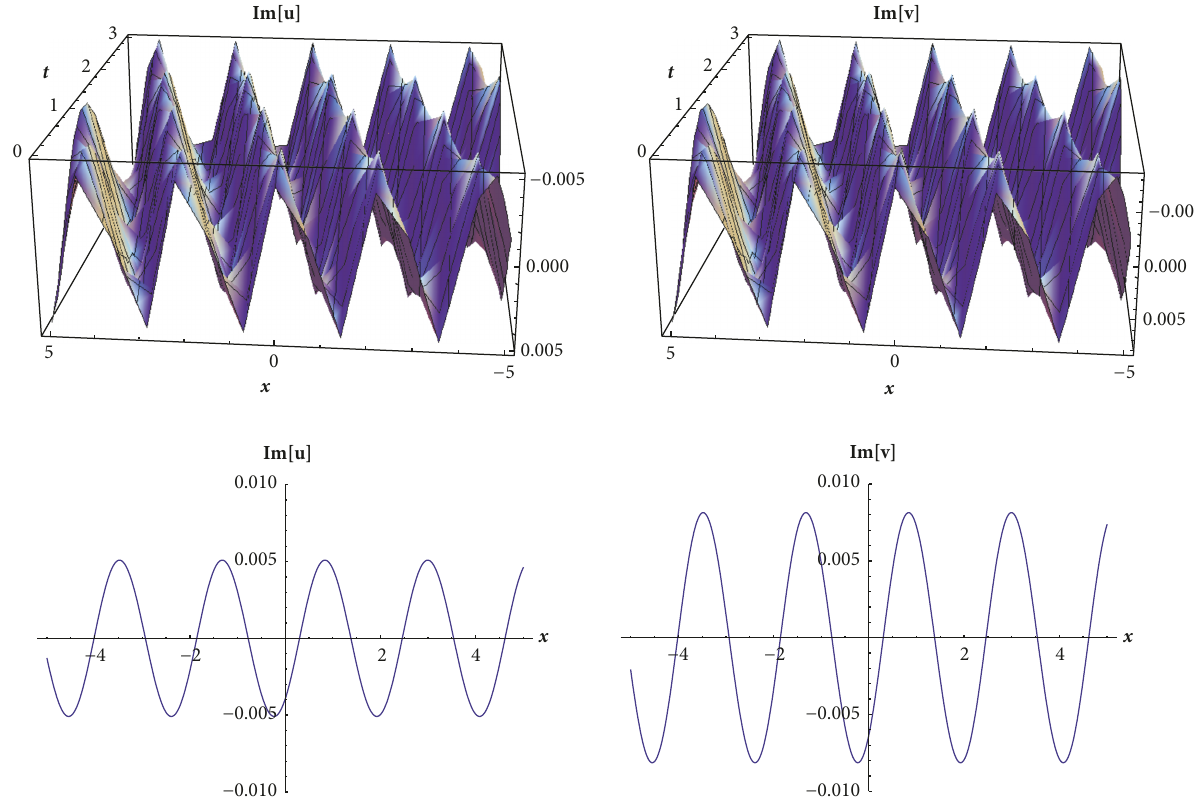
Figure 6: The 3D and 2D surfaces of the analytical solution (26) (imaginer part) by considering the values 𝑏 1 = 0.3 , 𝑎 1 = 0.2 , 𝑘 = 1.6 , 𝑐 = 0.8 , 𝑑 = 0.01 , 𝑦 = 1.5 , 𝜖 = 0.9 , and 𝑡 = 0.007 for 2𝐷